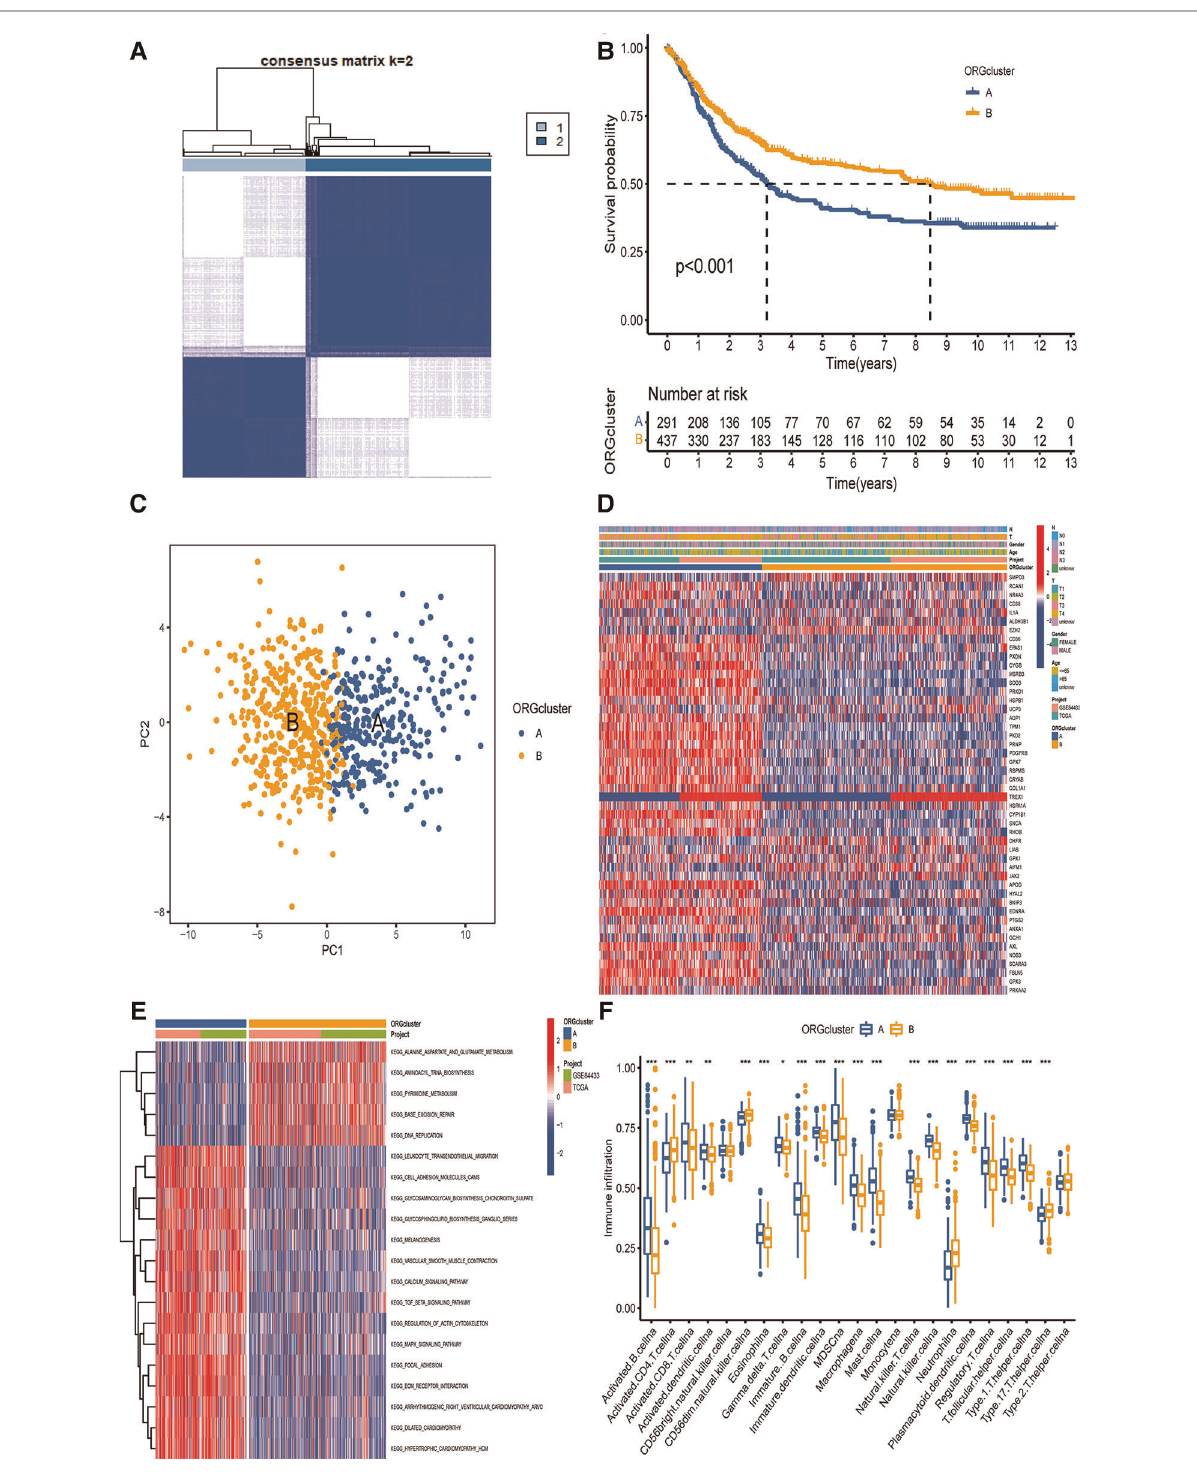
FIGURE 2 The determination of ORGcluster and the study of subtype function. ( A ) The patients with QC were divided into 292 cases in ORGcluster A and 440 cases in ORGcluster B by clustering algorithm. ( B ) PCA analysis of ORGcluster subtypes. ( C ) Differences in survival of ORGcluster subtypes. ( D ) Differences in clinical characteristics and gene expression of ORGcluster subtypes. ( E ) Study on the function of ORGs by GSVA. ( F ) Study on the difference of immune in fi ltrating cells of ORGcluster subtypes ORGcluster, the cluster of oxidative stress-related genes; GC, gastric cancer; PCA, principal components analysis; GSVA, gene set variation